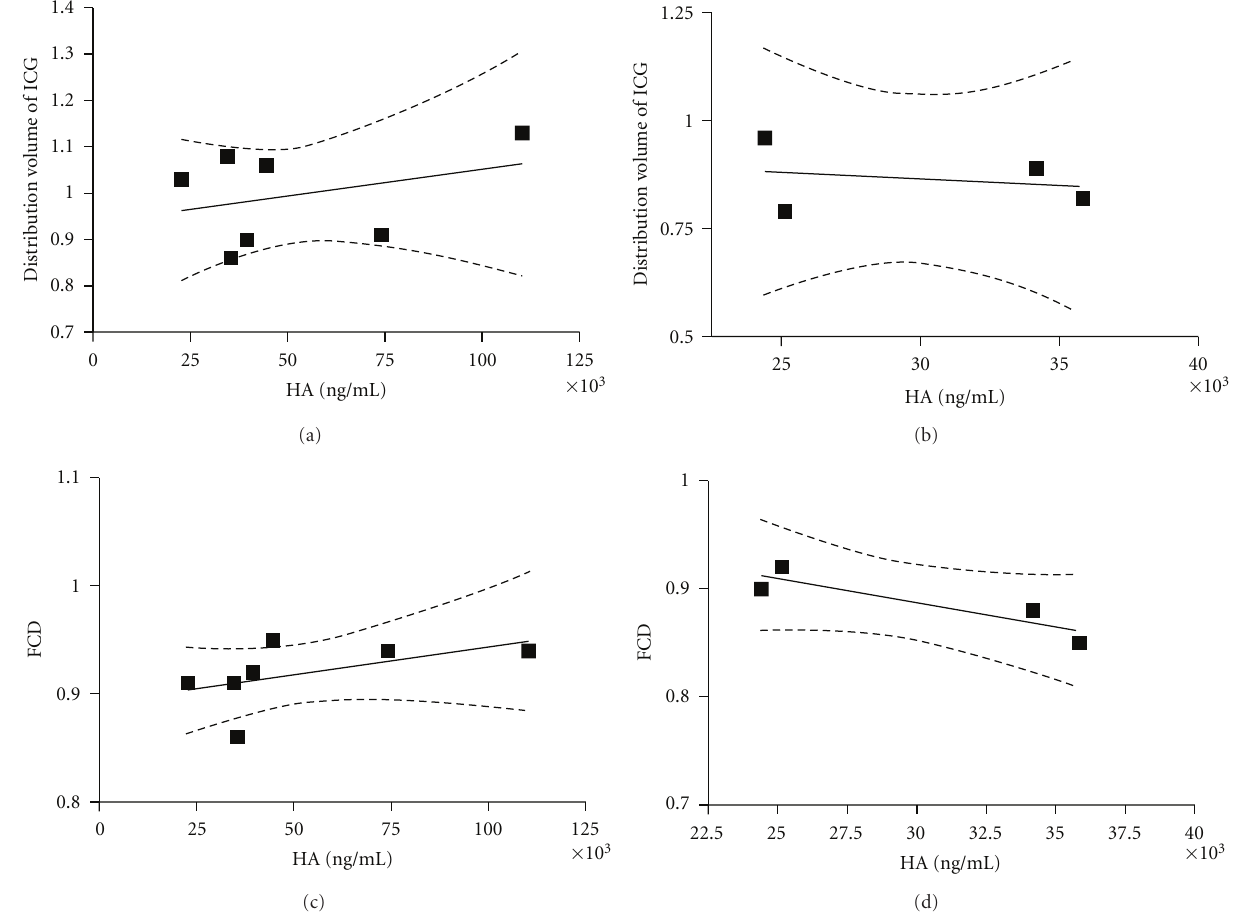
Figure 6: Correlation between plasma hyaluronan (HA) and the distribution volume of indocyanine green (ICG) after 45 and 120 minutes ((a) and (b)). The correlation between functional capillary density (FCD) is shown after 45 and 120 minutes ((c) and (d)). The confidence interval for the regression lines are marked as dotted lines and indicate no